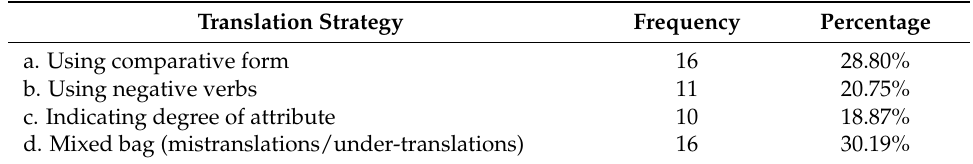
Table 3. Frequency and percentage of implicit negation strategies in rendering too negation.